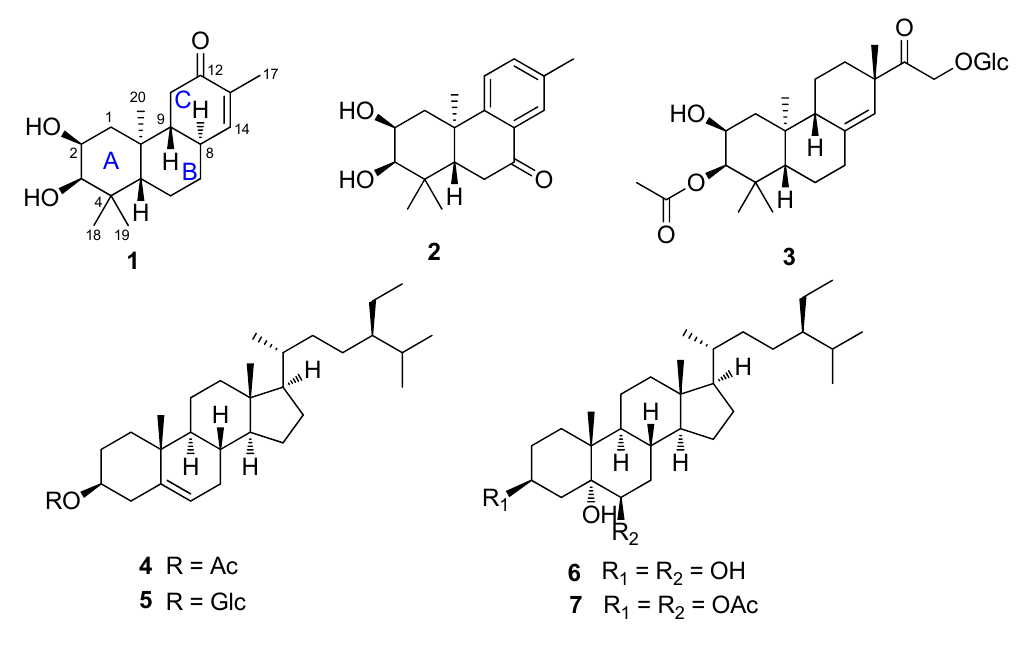
Figure 1. The structures of compounds 1 – 7